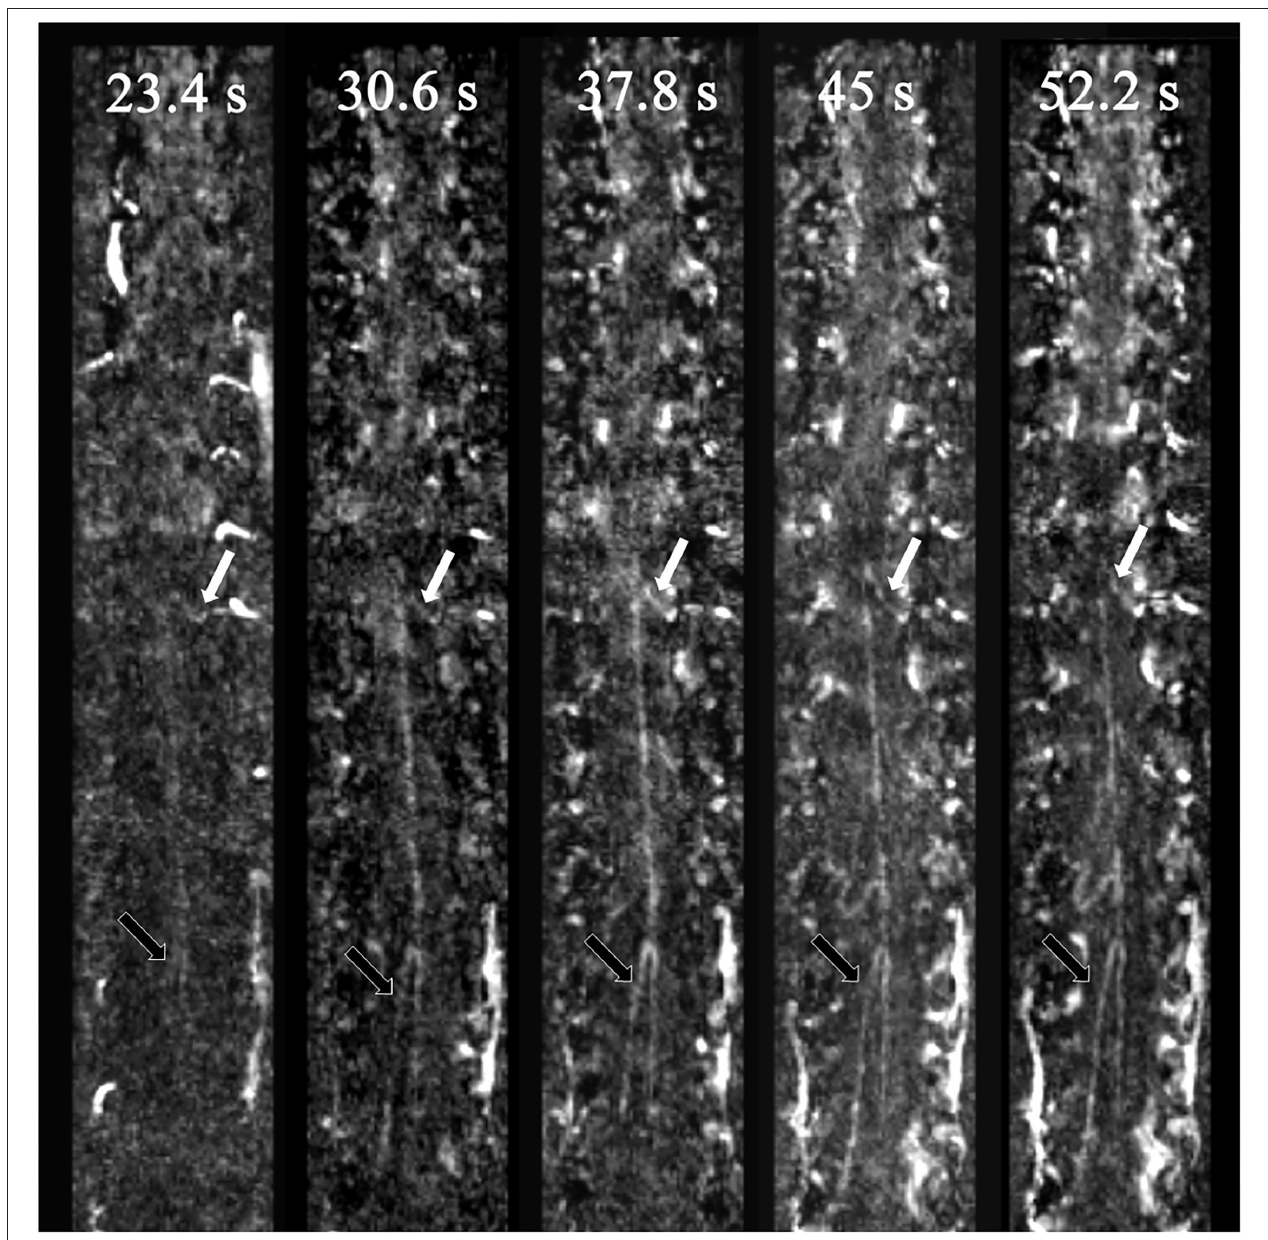
FIGURE 1 | Spinal vessels of a negative patient. The white arrows indicate the AKA, and the black arrows indicate the GARV. AKA enhancement occurred one phase earlier than that for the GARV. Therefore, the AKA and GARV were dynamically separated.